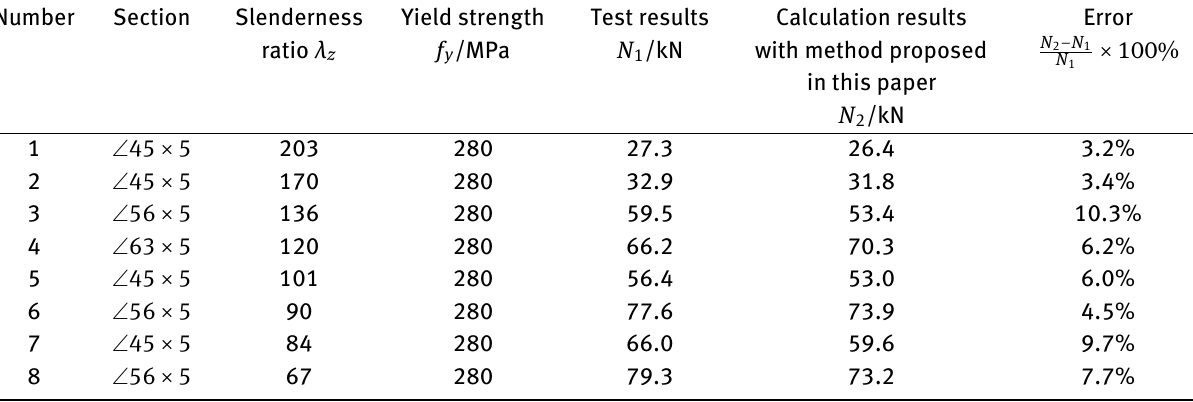
Table 3: Comparison between calculation results of presented method and experimental data Number